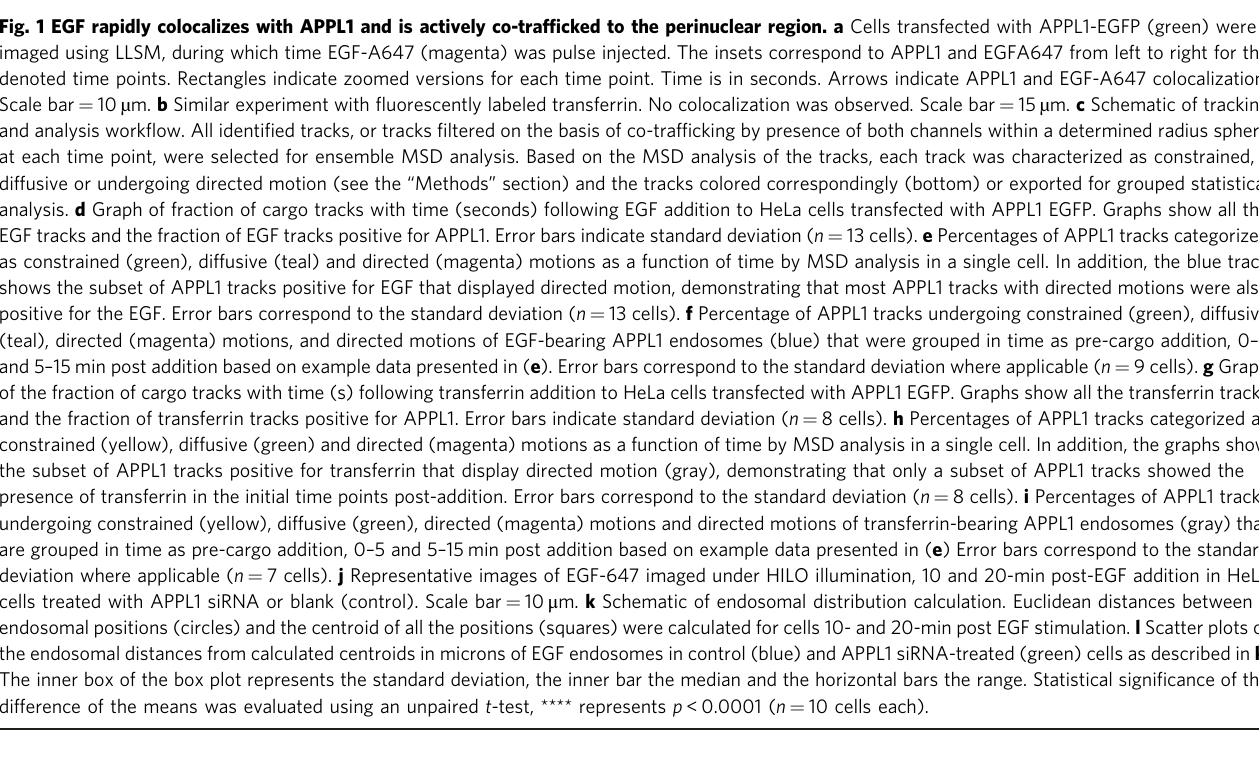
Fig. 1 EGF rapidly colocalizes with APPL1 and is actively co-traf fi cked to the perinuclear region. a Cells transfected with APPL1-EGFP (green) were imaged using LLSM, during which time EGF-A647 (magenta) was pulse injected. The insets correspond to APPL1 and EGFA647 from left to right for the denoted time points. Rectangles indicate zoomed versions for each time point. Time is in seconds. Arrows indicate APPL1 and EGF-A647 colocalization. Scale bar = 10 µ m. b Similar experiment with fl uorescently labeled transferrin. No colocalization was observed. Scale bar = 15 µ m. c Schematic of tracking and analysis work fl ow. All identi fi ed tracks, or tracks fi ltered on the basis of co-traf fi cking by presence of both channels within a determined radius sphere at each time point, were selected for ensemble MSD analysis. Based on the MSD analysis of the tracks, each track was characterized as constrained, diffusive or undergoing directed motion (see the “ Methods ” section) and the tracks colored correspondingly (bottom) or exported for grouped statistical analysis. d Graph of fraction of cargo tracks with time (seconds) following EGF addition to HeLa cells transfected with APPL1 EGFP. Graphs show all the EGF tracks and the fraction of EGF tracks positive for APPL1. Error bars indicate standard deviation ( n = 13 cells). e Percentages of APPL1 tracks categorized as constrained (green), diffusive (teal) and directed (magenta) motions as a function of time by MSD analysis in a single cell. In addition, the blue trace shows the subset of APPL1 tracks positive for EGF that displayed directed motion, demonstrating that most APPL1 tracks with directed motions were also positive for the EGF. Error bars correspond to the standard deviation ( n = 13 cells). f Percentage of APPL1 tracks undergoing constrained (green), diffusive (teal), directed (magenta) motions, and directed motions of EGF-bearing APPL1 endosomes (blue) that were grouped in time as pre-cargo addition, 0 – 5 and 5 – 15 min post addition based on example data presented in ( e ). Error bars correspond to the standard deviation where applicable ( n = 9 cells). g Graph of the fraction of cargo tracks with time (s) following transferrin addition to HeLa cells transfected with APPL1 EGFP. Graphs show all the transferrin tracks and the fraction of transferrin tracks positive for APPL1. Error bars indicate standard deviation ( n = 8 cells). h Percentages of APPL1 tracks categorized as constrained (yellow), diffusive (green) and directed (magenta) motions as a function of time by MSD analysis in a single cell. In addition, the graphs show the subset of APPL1 tracks positive for transferrin that display directed motion (gray), demonstrating that only a subset of APPL1 tracks showed the presence of transferrin in the initial time points post-addition. Error bars correspond to the standard deviation ( n = 8 cells). i Percentages of APPL1 tracks undergoing constrained (yellow), diffusive (green), directed (magenta) motions and directed motions of transferrin-bearing APPL1 endosomes (gray) that are grouped in time as pre-cargo addition, 0 – 5 and 5 – 15 min post addition based on example data presented in ( e ) Error bars correspond to the standard deviation where applicable ( n = 7 cells). j Representative images of EGF-647 imaged under HILO illumination, 10 and 20-min post-EGF addition in HeLa cells treated with APPL1 siRNA or blank (control). Scale bar = 10 μ m. k Schematic of endosomal distribution calculation. Euclidean distances between endosomal positions (circles) and the centroid of all the positions (squares) were calculated for cells 10- and 20-min post EGF stimulation. l Scatter plots of the endosomal distances from calculated centroids in microns of EGF endosomes in control (blue) and APPL1 siRNA-treated (green) cells as described in k . The inner box of the box plot represents the standard deviation, the inner bar the median and the horizontal bars the range. Statistical signi fi cance of the difference of the means was evaluated using an unpaired t -test, **** represents p < 0.0001 ( n = 10 cells